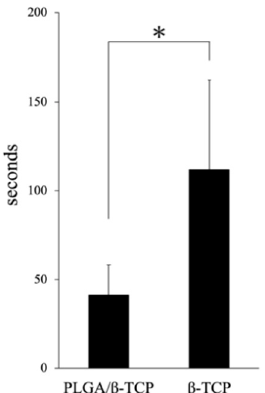
Figure 6. The time required for material graft. *: p < 0.05, significant difference.